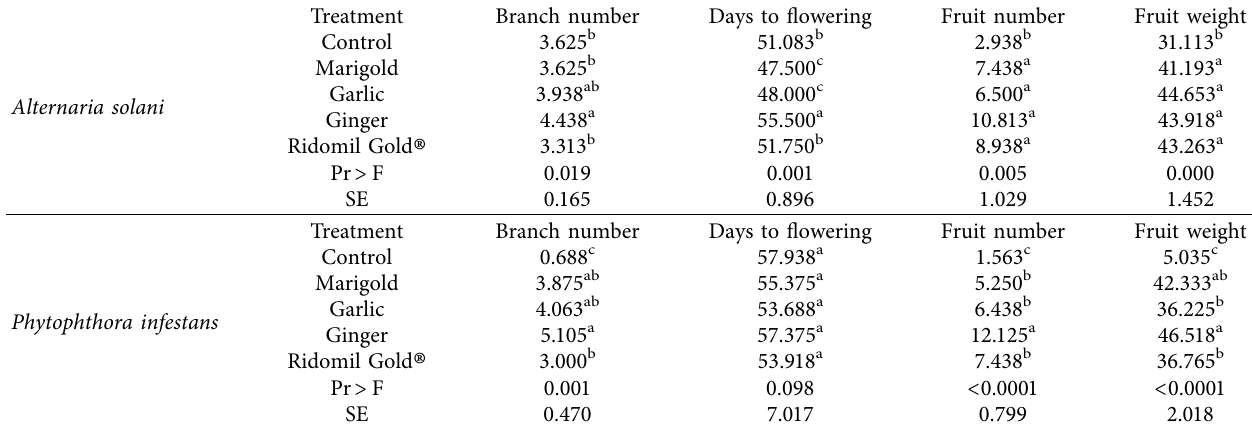
Table 7: Effects of essential oils on growth and yield of tomato.